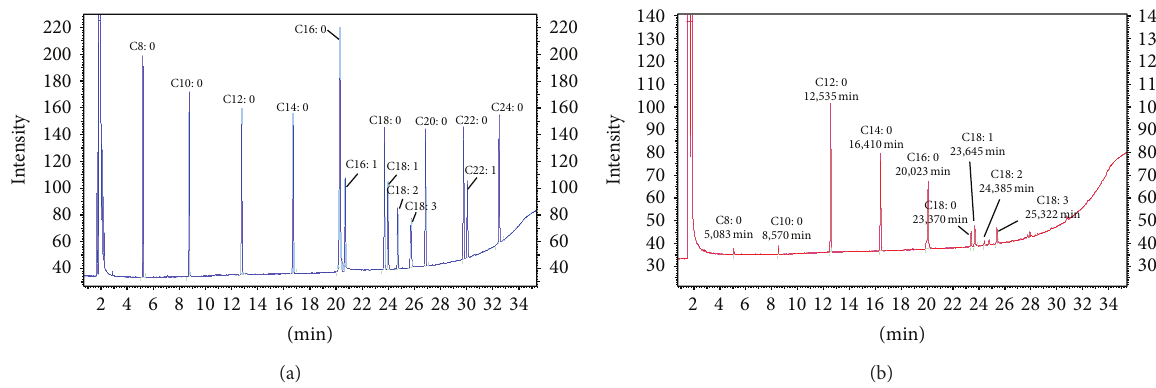
Figure 2: Chromatogram: (a) standards of fatty acids (C8–C24), (b) mixture of 1 a , 2 a , and 3 a wash waters from biodiesel.